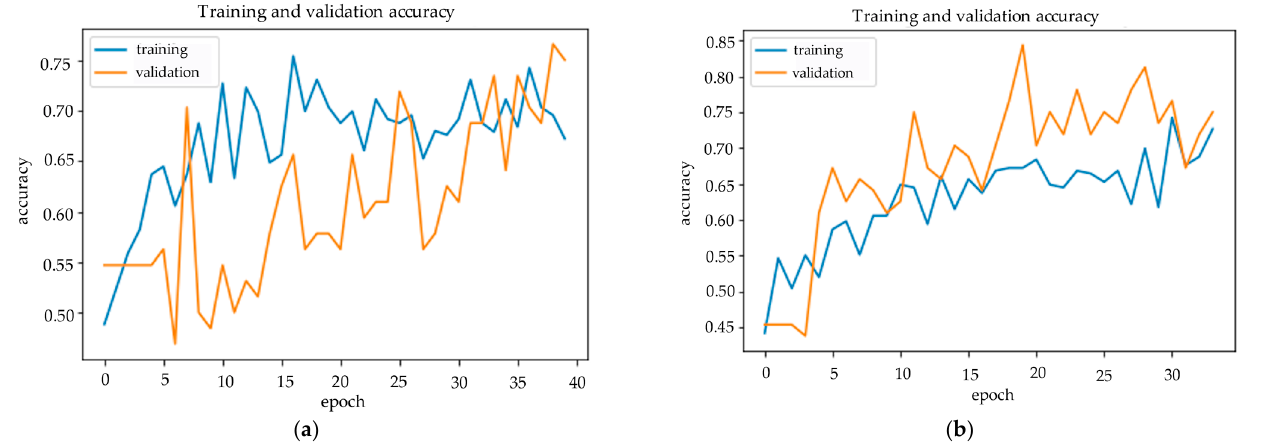
Figure 9. Training history of ( a ) DenseNet and ( b ) Hybrid EfficientNet-DOLG on the COVID-19 severity assessment task